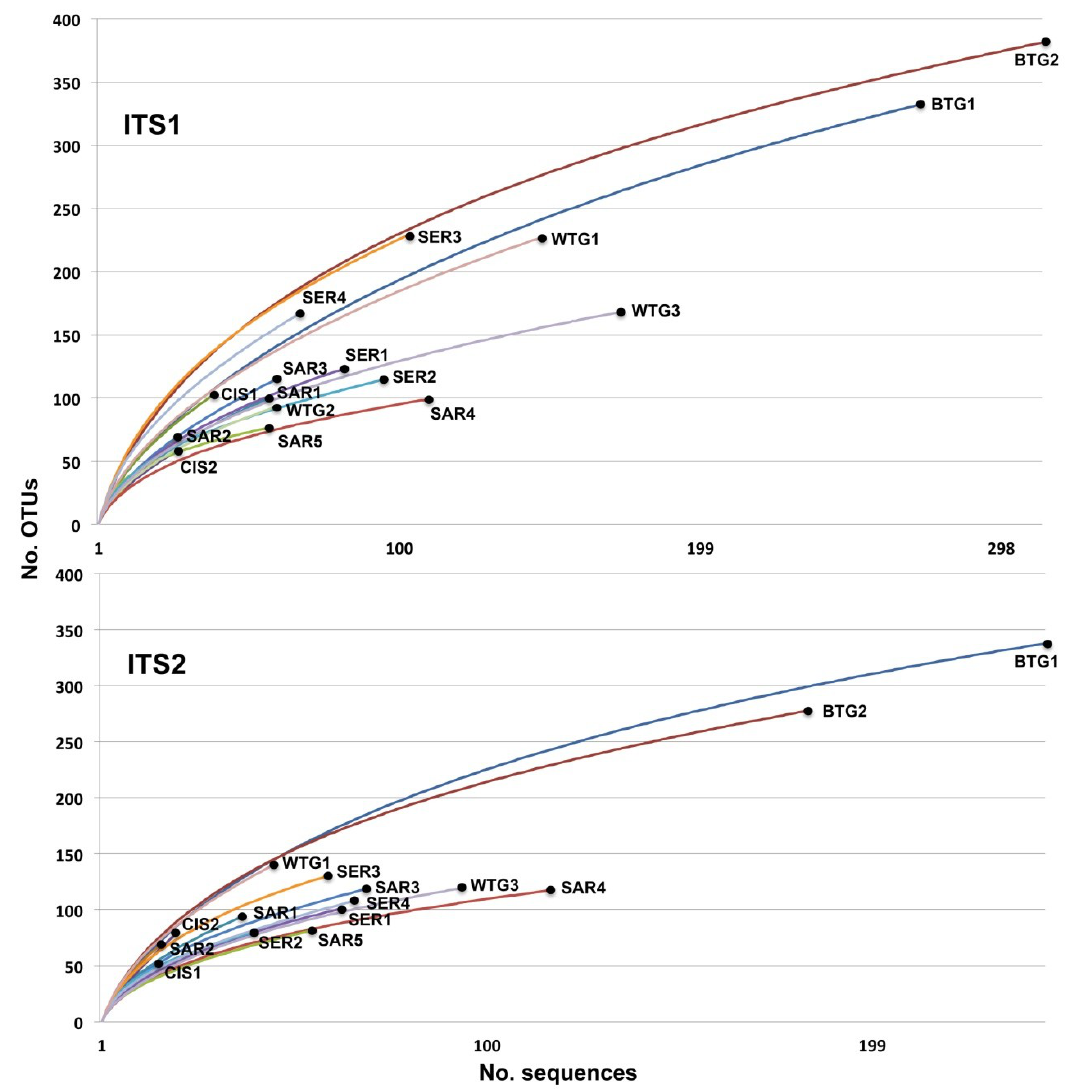
operational taxonomic units (OTUs) as a function of the sequencing effort per soil plot (rarefaction index values were calculated at intervals of 10 sequences). WTG: white truffle grounds; BTG: black truffle grounds; SAR: Sardinian soils; SER: serpentinitic substrate samples; CIS: contaminated industrial